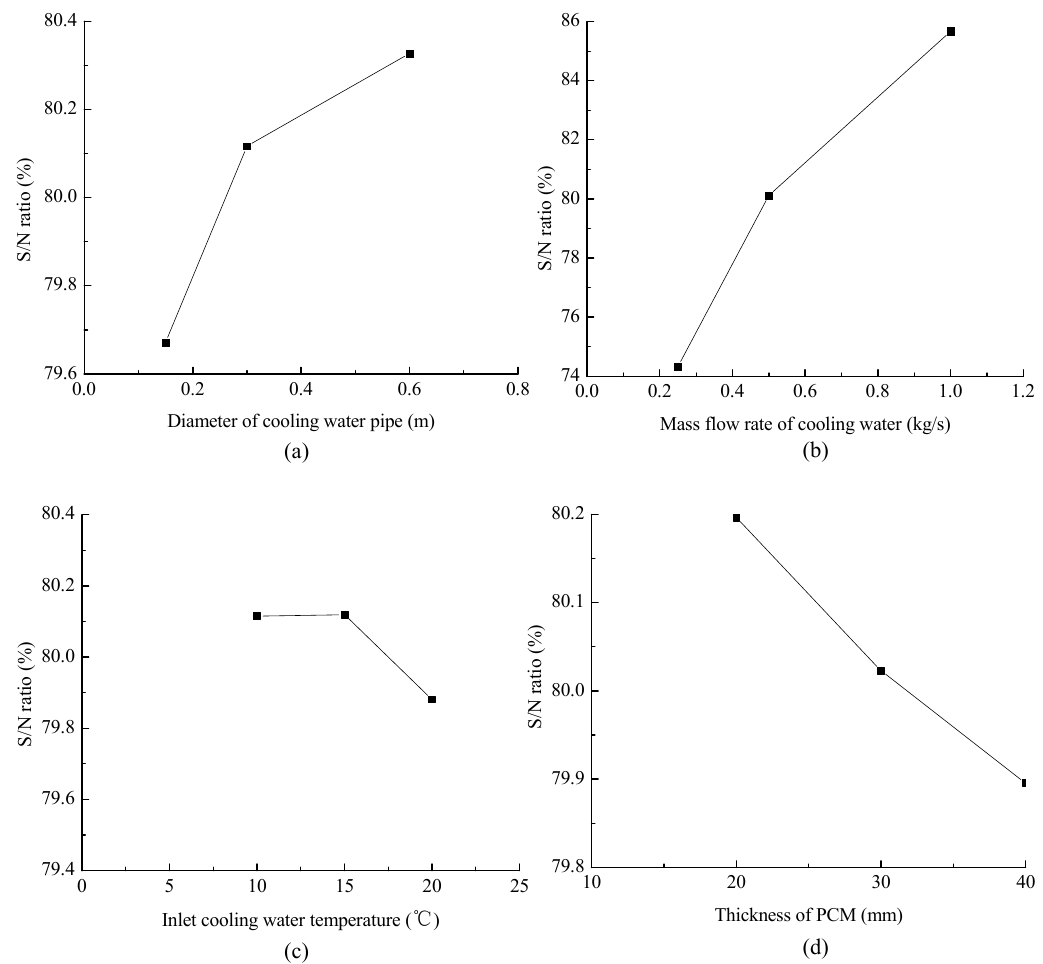
Figure 4. Average value of S/N ratios for the equivalent overall output energy.